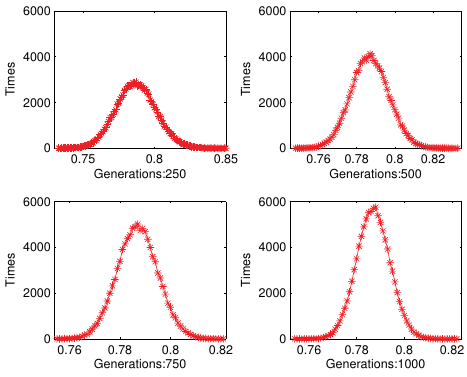
Figure 4: The distribution of the joint spectral radius under di ff erent numbers of generations. rise to small and large variance of spectral radius,